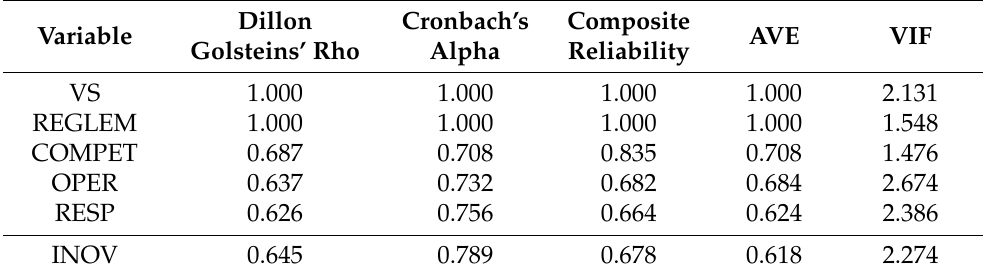
Table 3. Validity of model